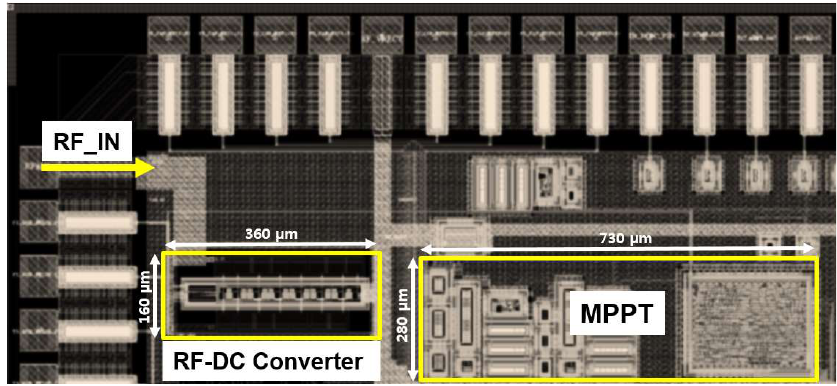
Figure 8. Layout pattern of the chip of the proposed reconfigurable RF–DC converter.